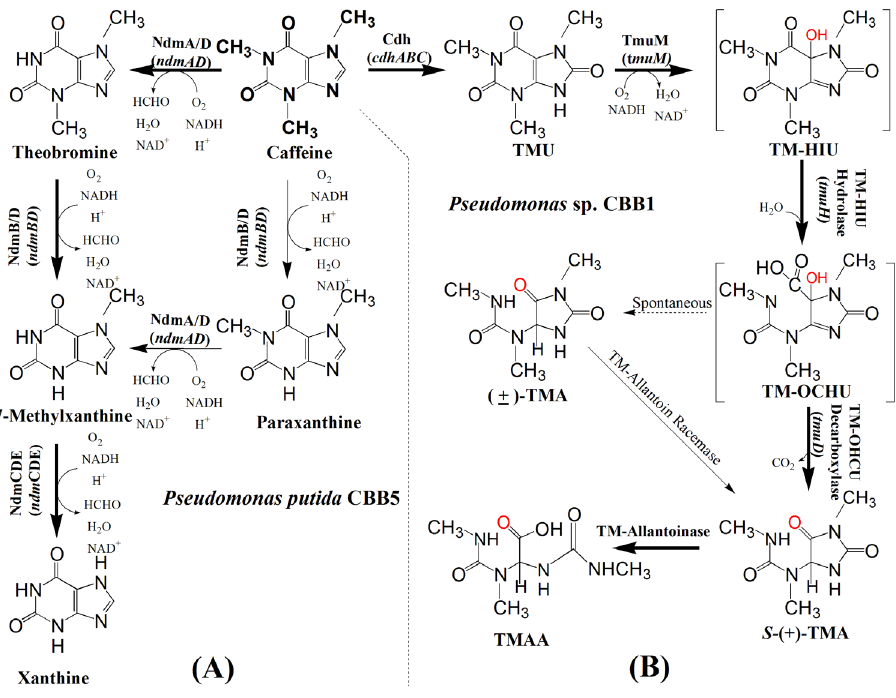
Figure 1. Caffeine degradation in Pseudomonas putida CBB5 (A) and Pseudomonas sp. CBB1 (B) with appropriate gene